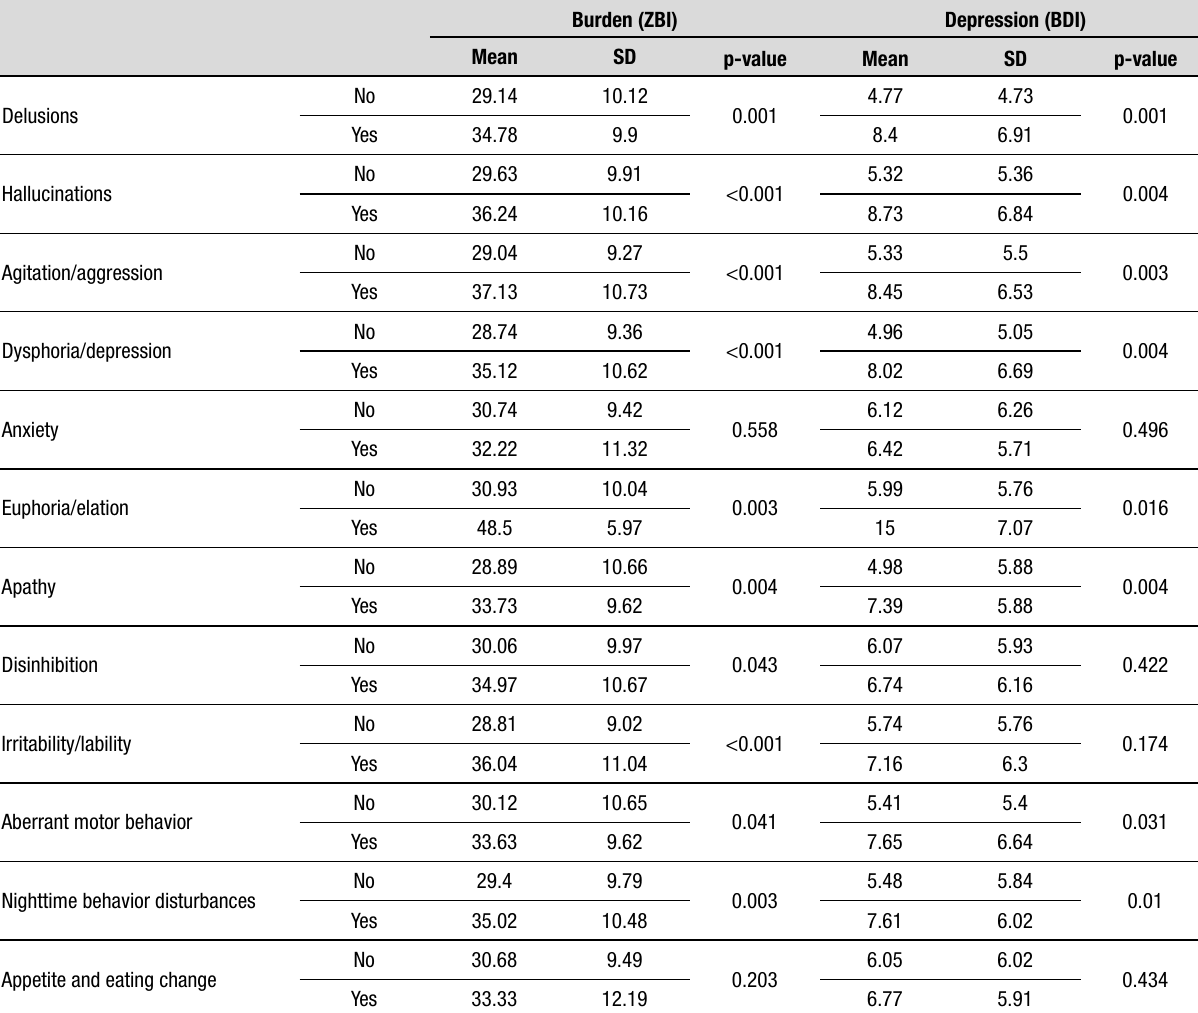
Table 3. Mean values and standard deviation of burden and depression for each neuropsychiatric symptom of the Neuropsychiatric Inventory. Burden